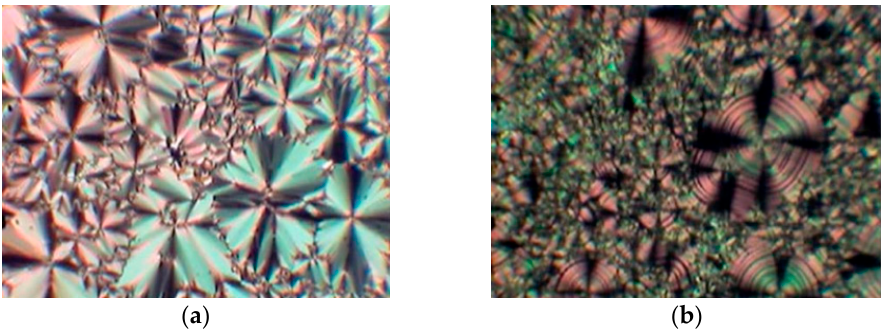
Figure 2. The optical photomicrograph of compound 1e with ( a ) SmA and ( b ) SmE phase textures. Reprinted/adapted with permission from Ref. [25]; published by Elsevier, 2011.